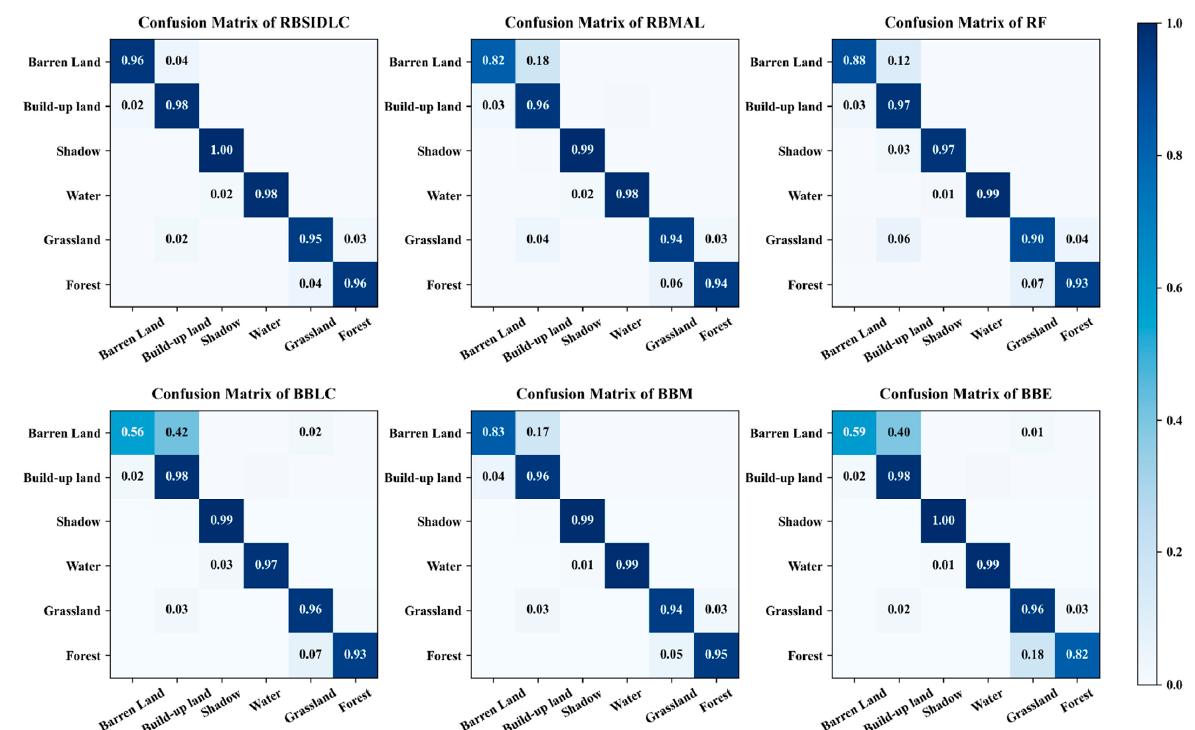
Figure 9. Confusion matrix of the classification results of six algorithms based on preferred features.